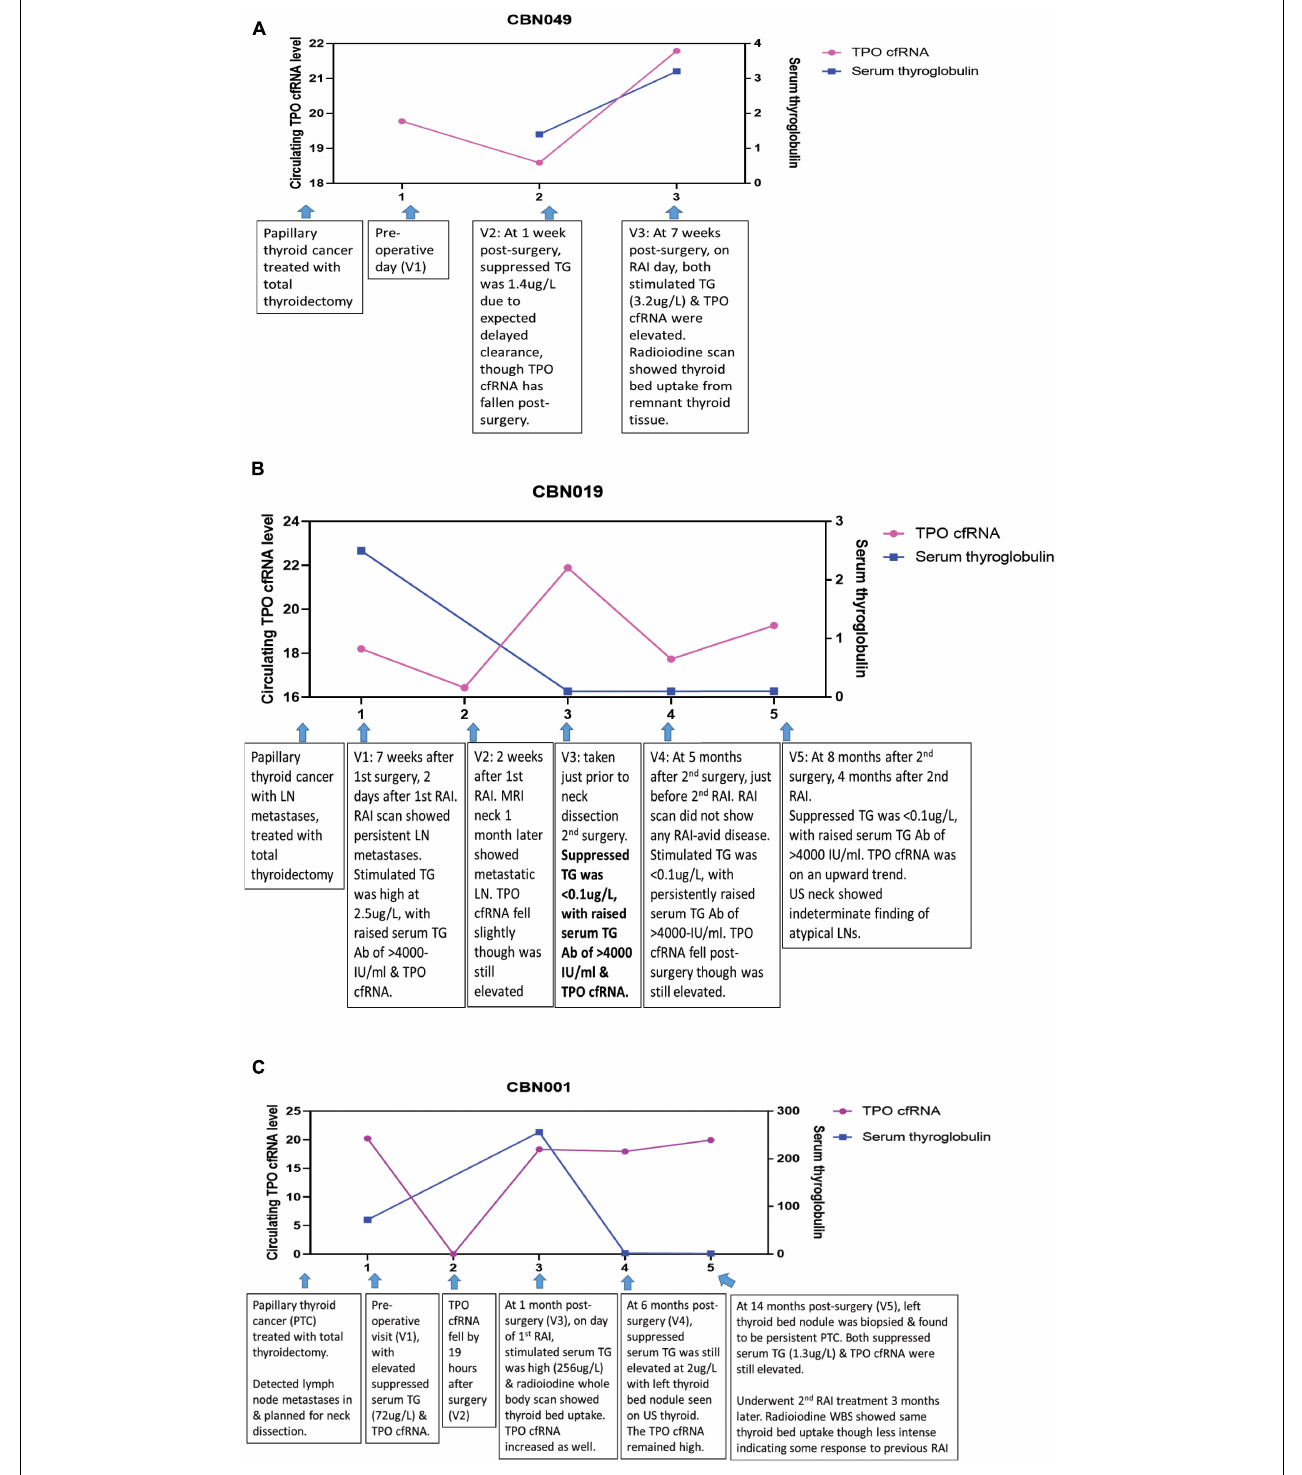
FIGURE 4 | Longitudinal trend of thyroid-specific cfRNA in clinical course of thyroid cancer patients. The circulating cfRNA levels plotted along Y-axis were derived from 60- Ct values. (A) Peri-operative and pre-RAI TPO cfRNA level and serum thyroglobulin level at three time points in patient with papillary thyroid cancer. (B) TPO cfRNA level and serum thyroglobulin (TG) level in the setting of positive thyroglobulin antibody (TG Ab) in patient with papillary thyroid cancer and lymph node (LN) metastases. (C) TPO cfRNA level and serum thyroglobulin (TG) level in a patient with papillary thyroid cancer and persistent lymph node (LN) metastases undergoing further ablative